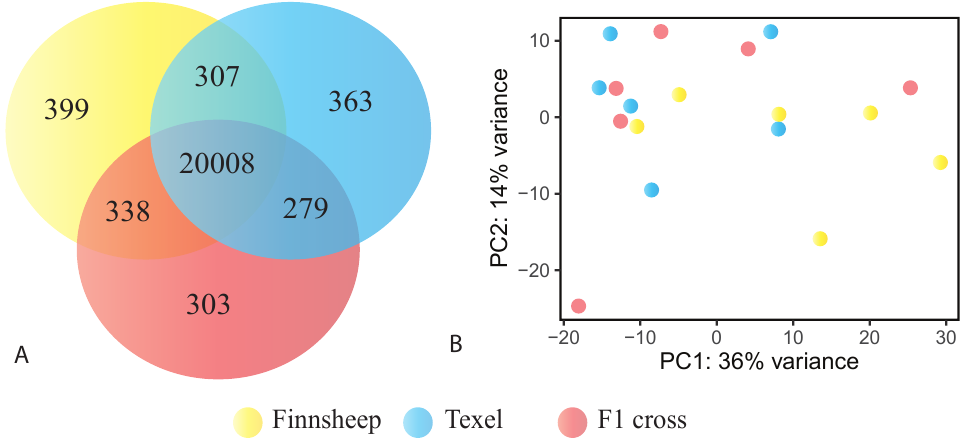
Figure 1. Graphical summary of gene expression in the corpus luteum (CL). ( A ) Shared and unique genes expressed in the CL of Finnsheep, Texel and their F1. ( B ) Principal component analysis (PCA) plot based on variance stabilized transformation (VST) of gene expression counts derived from DESeq2 in three